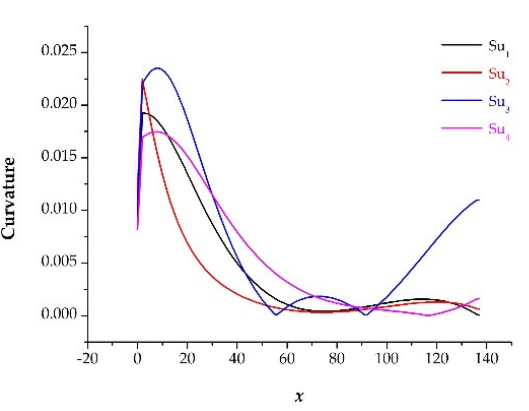
Figure 16. Curvature characteristics of the contour line of each bionic liquid fertilizer deep application opener.